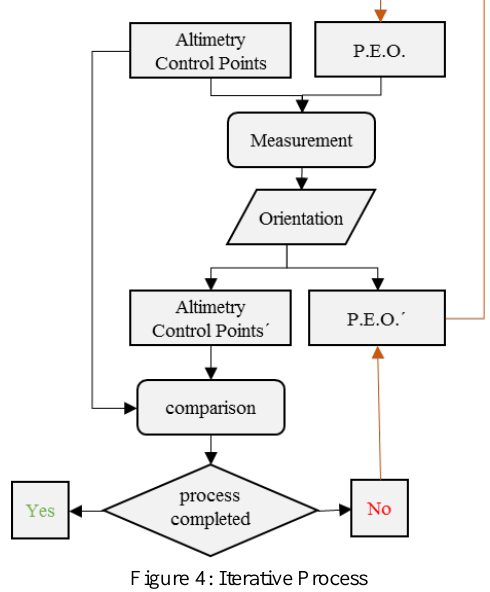
Figure 4: Iterative Process